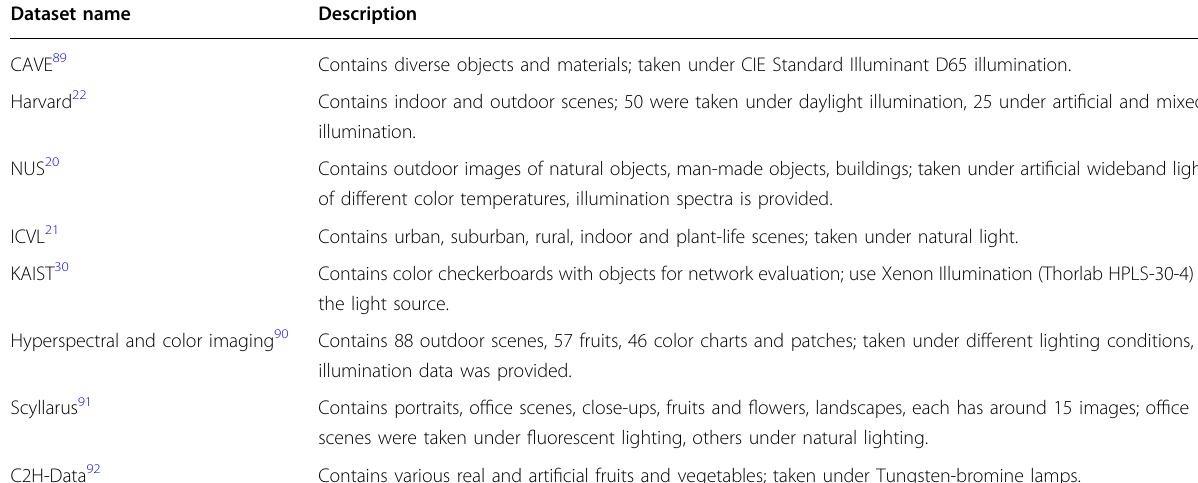
Table 4 Description of spectral